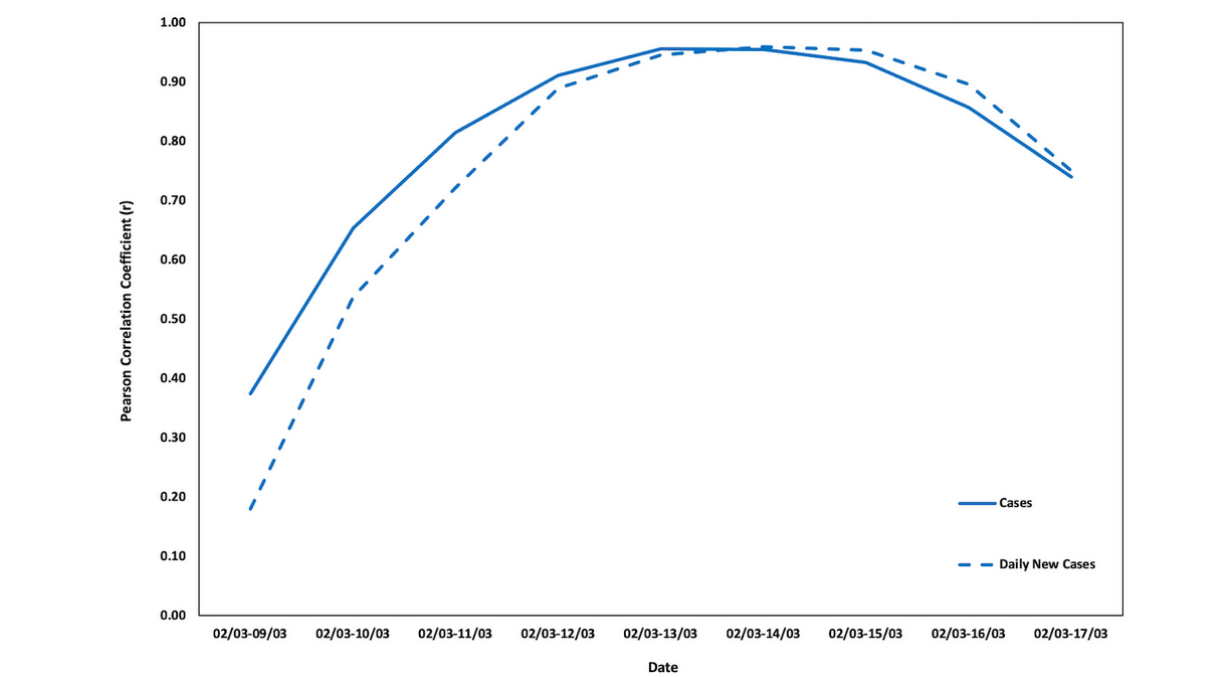
Figure 7. Changes in the Pearson correlation coefficients ( r ) for